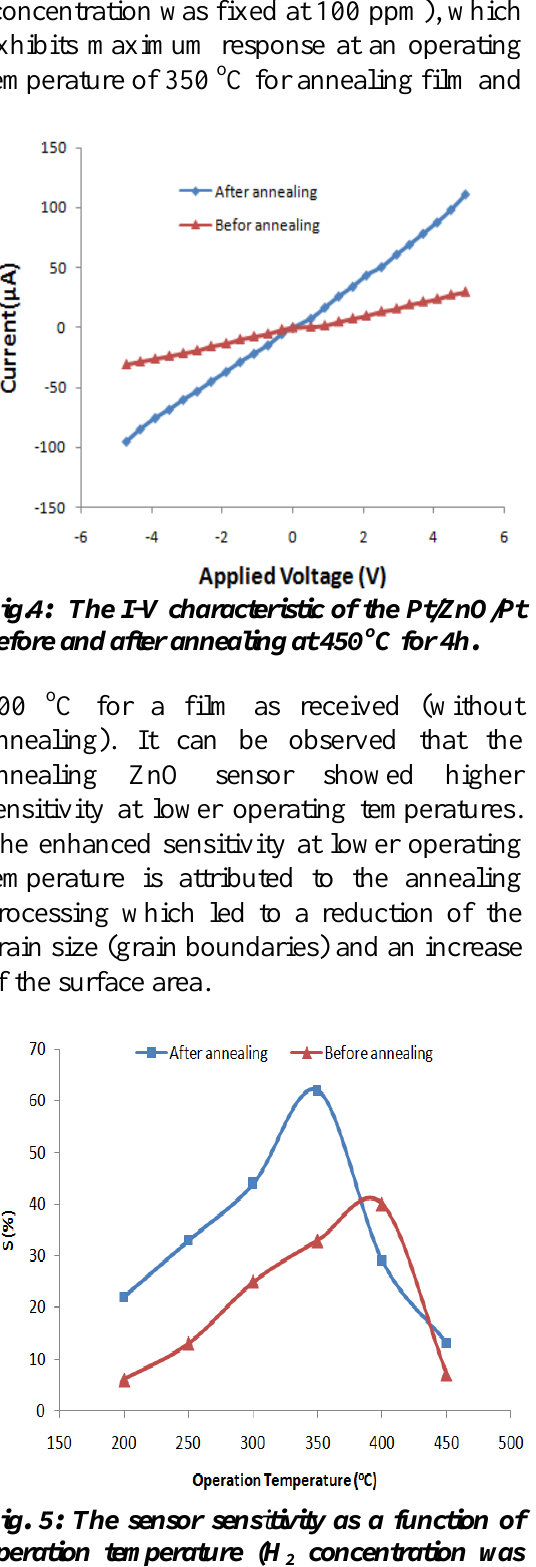
concentration was 2